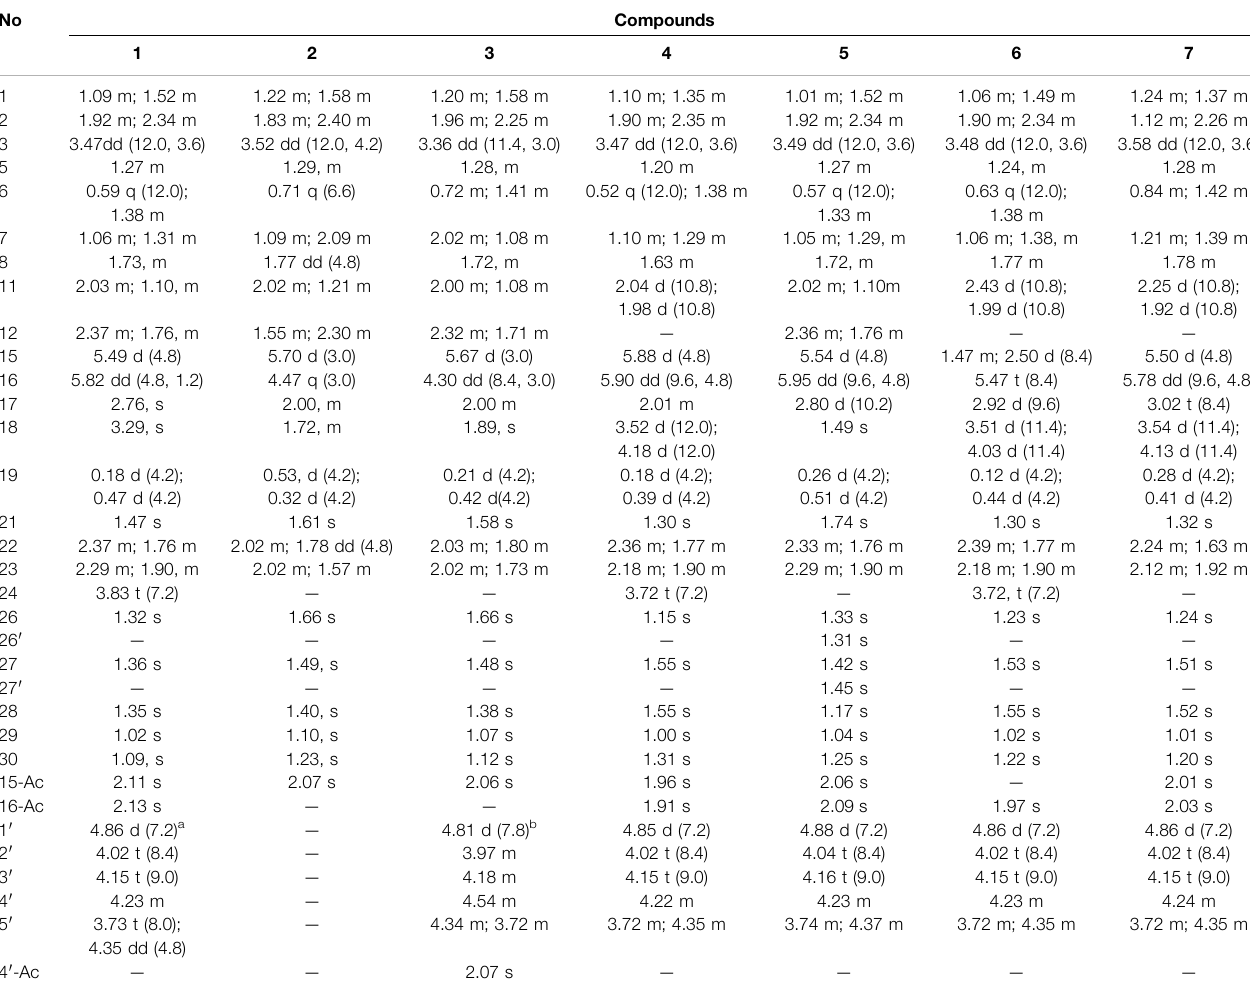
TABLE 1 | 1 H NMR Spectroscopic Data (600 MHz, in pyridine- d